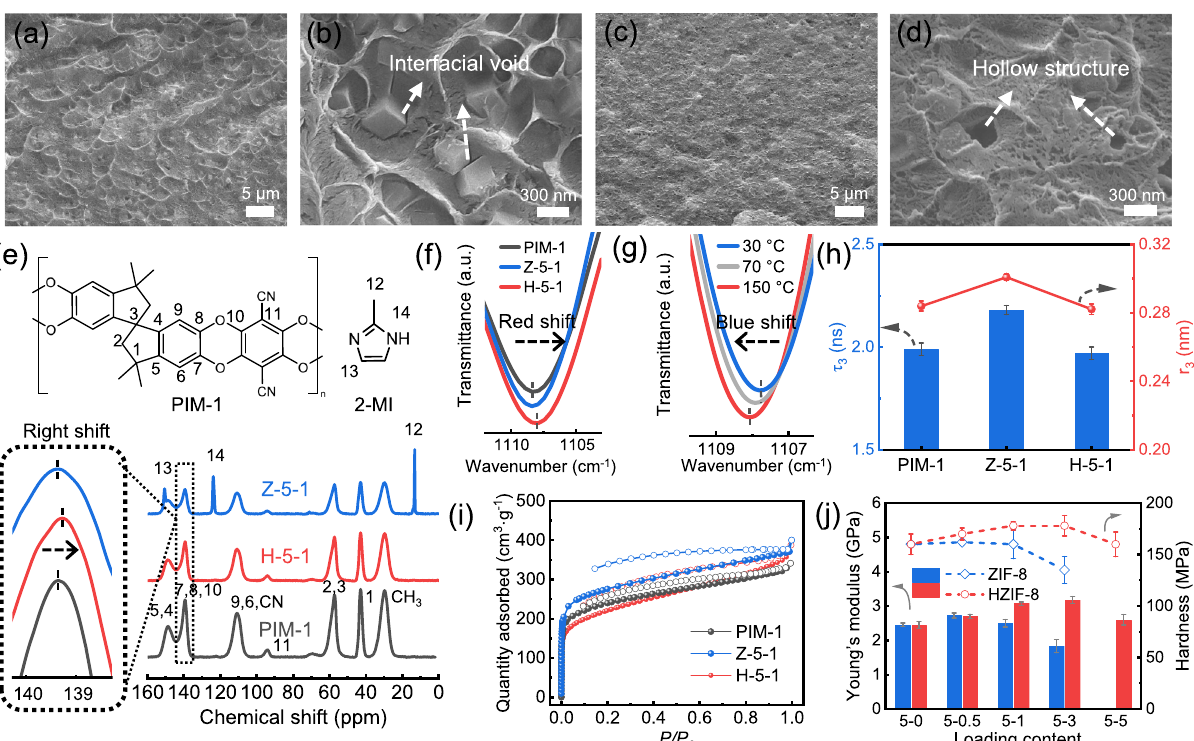
Fig. 2 | Membrane characterizations. a – d SEM images of cross-sections of Z-5-1 ( a , b ) and H-5-1 ( c , d ); e Solid 13 C nuclear magnetic resonance (NMR) spectroscopy ofPIM-1,Z-5-1,andH-5-1; f FT-IRspectraofaromaticethergroupinPIM-1,Z-5-1,and H-5-1membranes; g Temperaturedependenceof aromaticethergroup absorption from 30°C to 150°C in H-5-1 membranes; h Positron annihilation